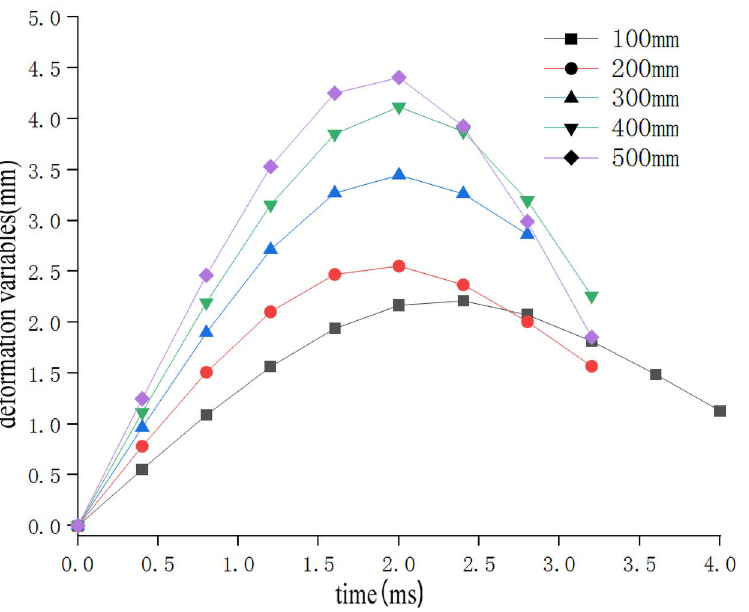
Fig 7. Impact deformation-time relationship during drop impact at different